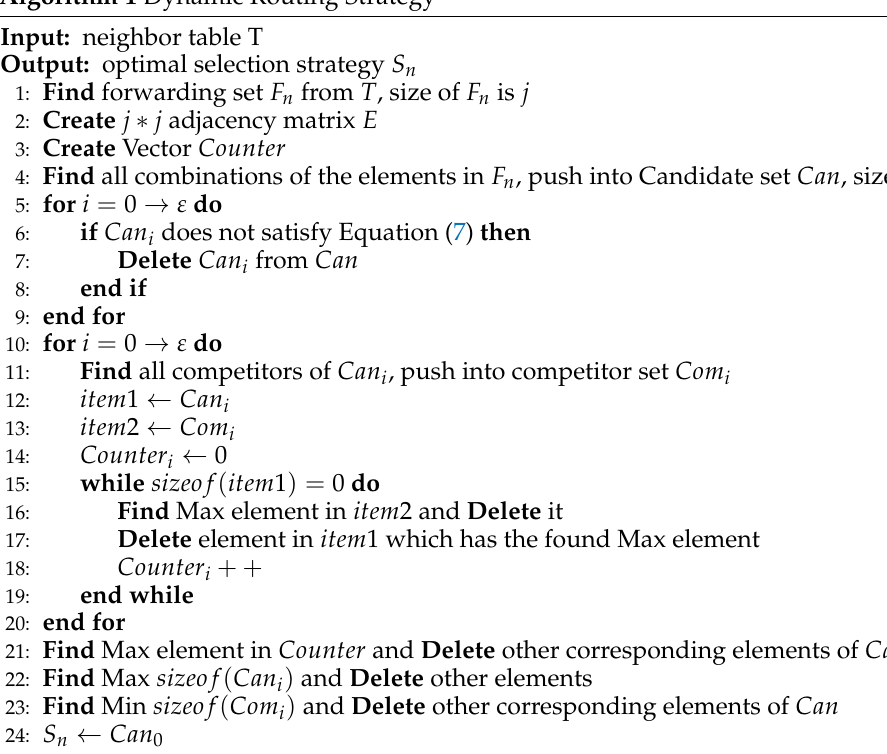
Algorithm 1 Dynamic Routing